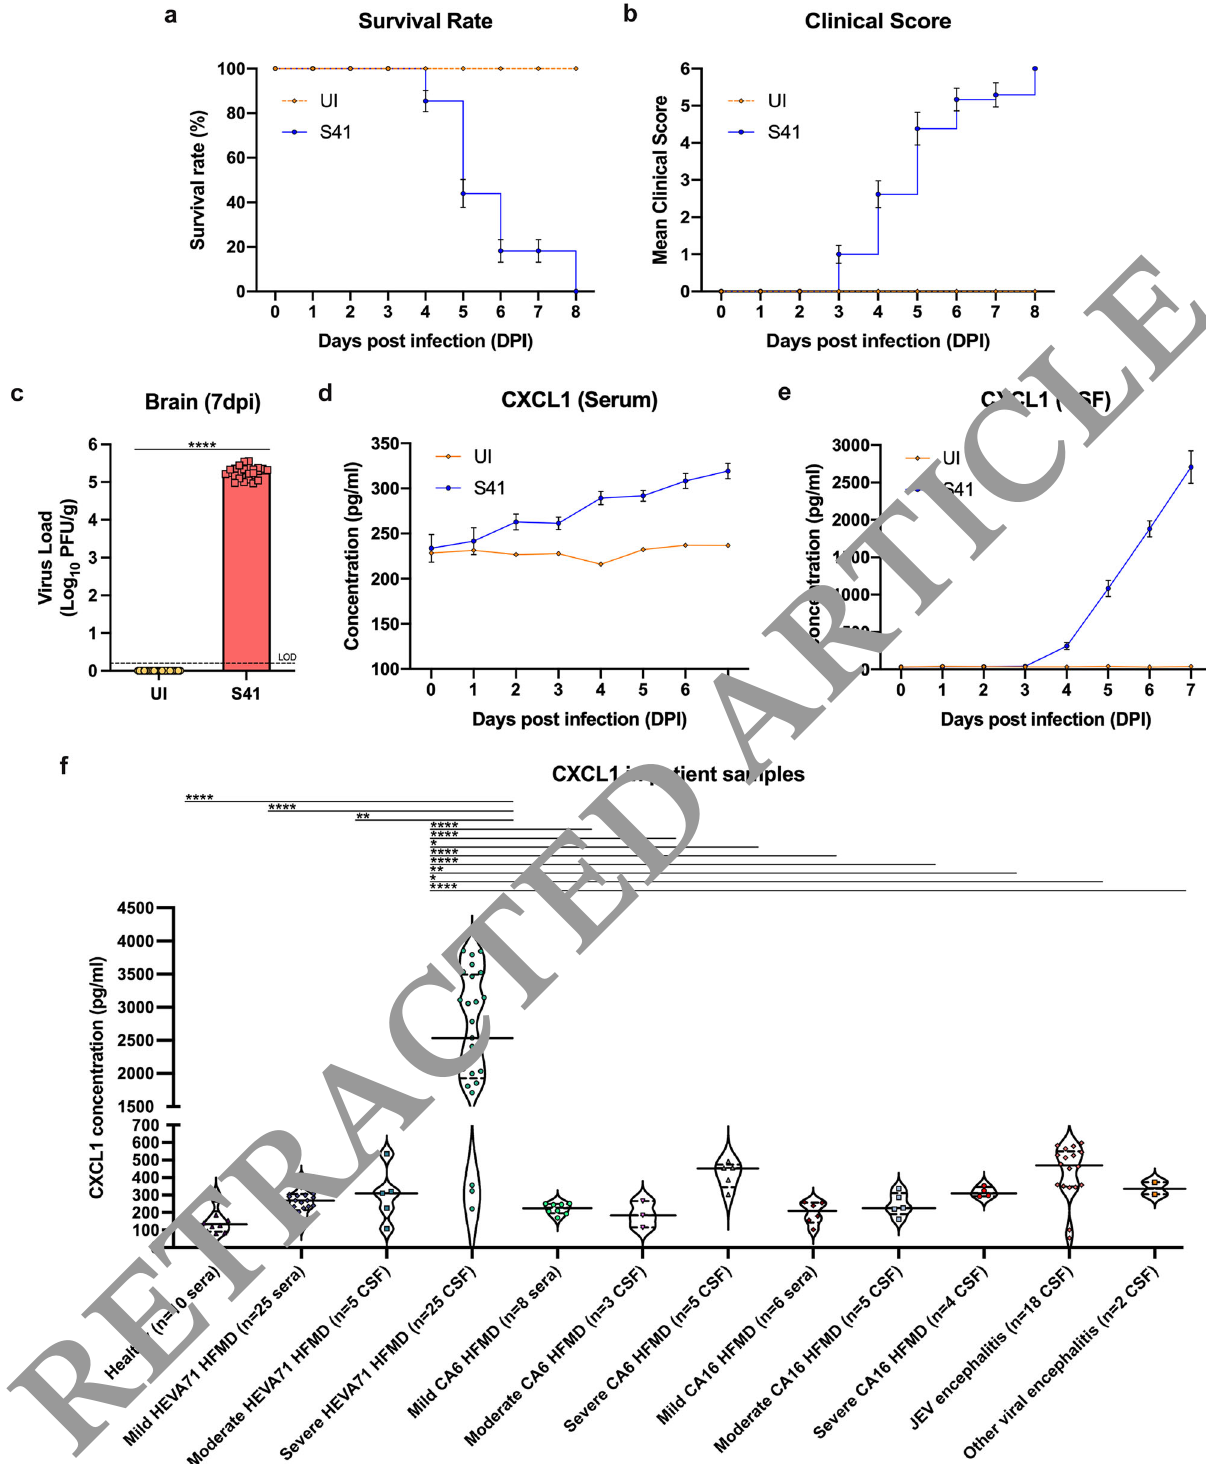
(Supplementary Fig. 15m). These results reiterate the speci fi city of VP4-induced CXCL1 signaling in